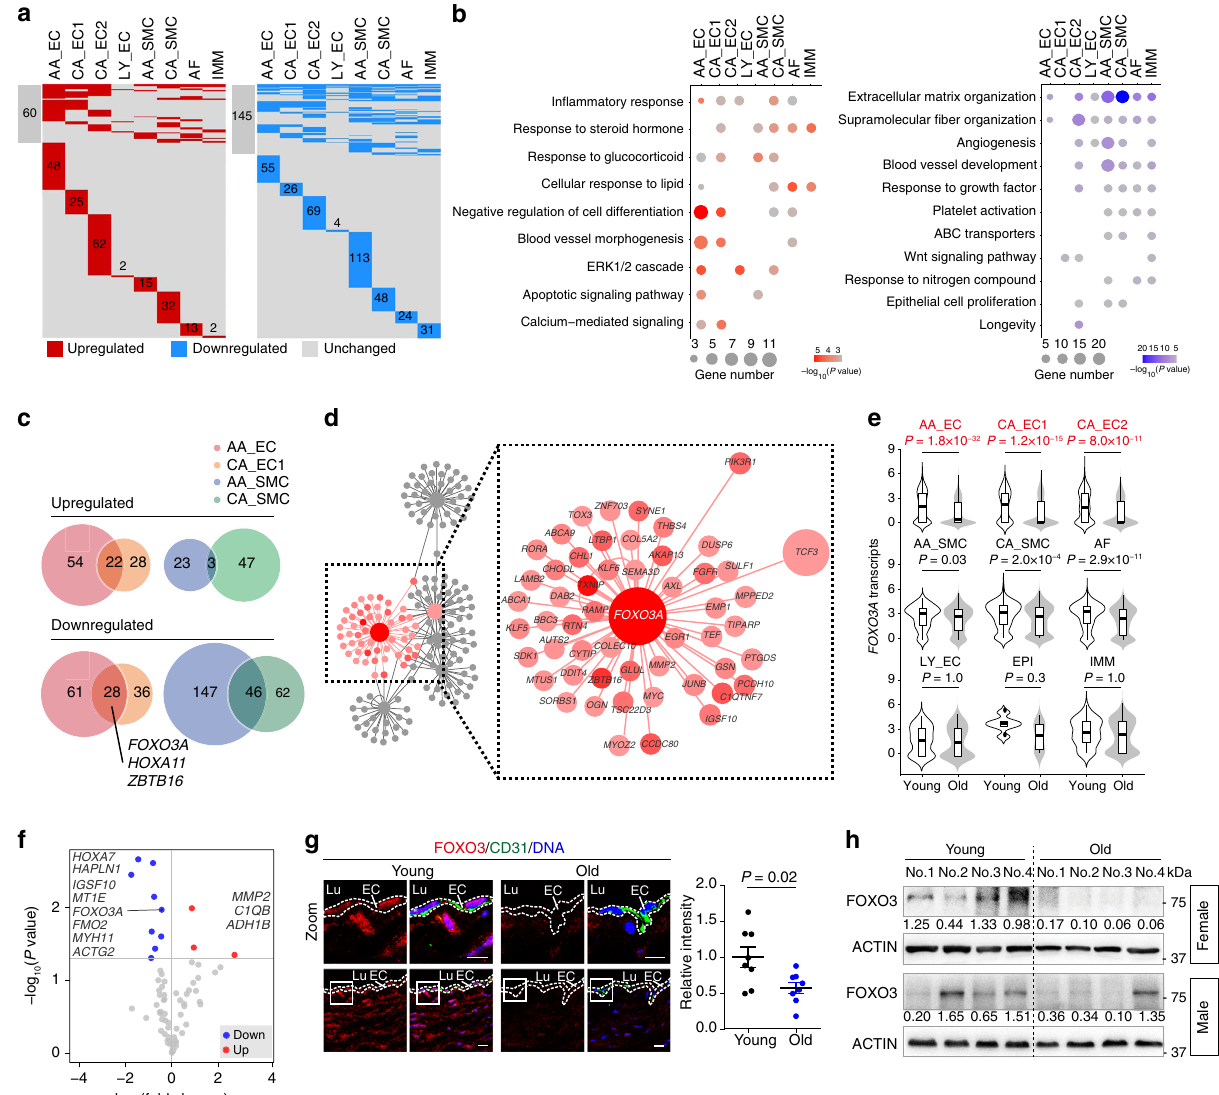
Fig. 3 Gene regulatory network uncovers FOXO3A at the hub of aging regulation. a Heatmap showing the differentially expressed genes (O/Y DEGs, Bonferroni-corrected p value ≤ 0.05 and log 2 [fold change] ≥ 0.5) for each cell type from young and old monkeys. P values were determined by two-sided Wilcoxon rank sum tests. Rows represent genes and columns are cell types. Red, upregulated genes; blue, downregulated genes; gray, genes not differentially expressed. The number of O/Y DEGs in at least two cell populations is shown in the gray rectangles; the number of O/Y DEGs uniquely differentially expressed in each cell type is shown in the colored rectangles. See Fig. 1 for cell-type abbreviations. b GO analysis of differentially expressed genes. Red, upregulated pathways; blue, downregulated pathways. c Venn diagrams of upregulated and downregulated genes shared in AA_EC/SMC and CA_EC1/SMC of old monkeys. d Network visualization of potential transcriptional regulation in the vessels. Node size is positively correlated with the number of directed edges. Nodes and edges that directly bind to the node of FOXO3A are highlighted in red; others are gray. Red is positively correlated with the number of motif-binding sites (darker red re fl ects more motifs). Dashed square, enlarged area. e Violin plots with box plots inside showing FOXO3A expression across cell types. f Volcano plot of O/Y DEGs ( p value ≤ 0.05, two-sided Student ’ s t test) veri fi ed by qPCR. Blue dots, downregulated genes; red dots, upregulated genes. g Left, immuno fl uorescence staining for FOXO3A and CD31 in the aortic artery. Right, quanti fi cation of immuno fl uorescence intensity in young and old vessel samples. Lu lumen, EC endothelial cells. Scale bar, 10 μ m. Data are presented the means ± SEM; n = 8 monkeys; p values were determined by two-sided Student ’ s t test. h Western blotting and band intensity quanti fi cation of FOXO3 protein levels in young and old vessel